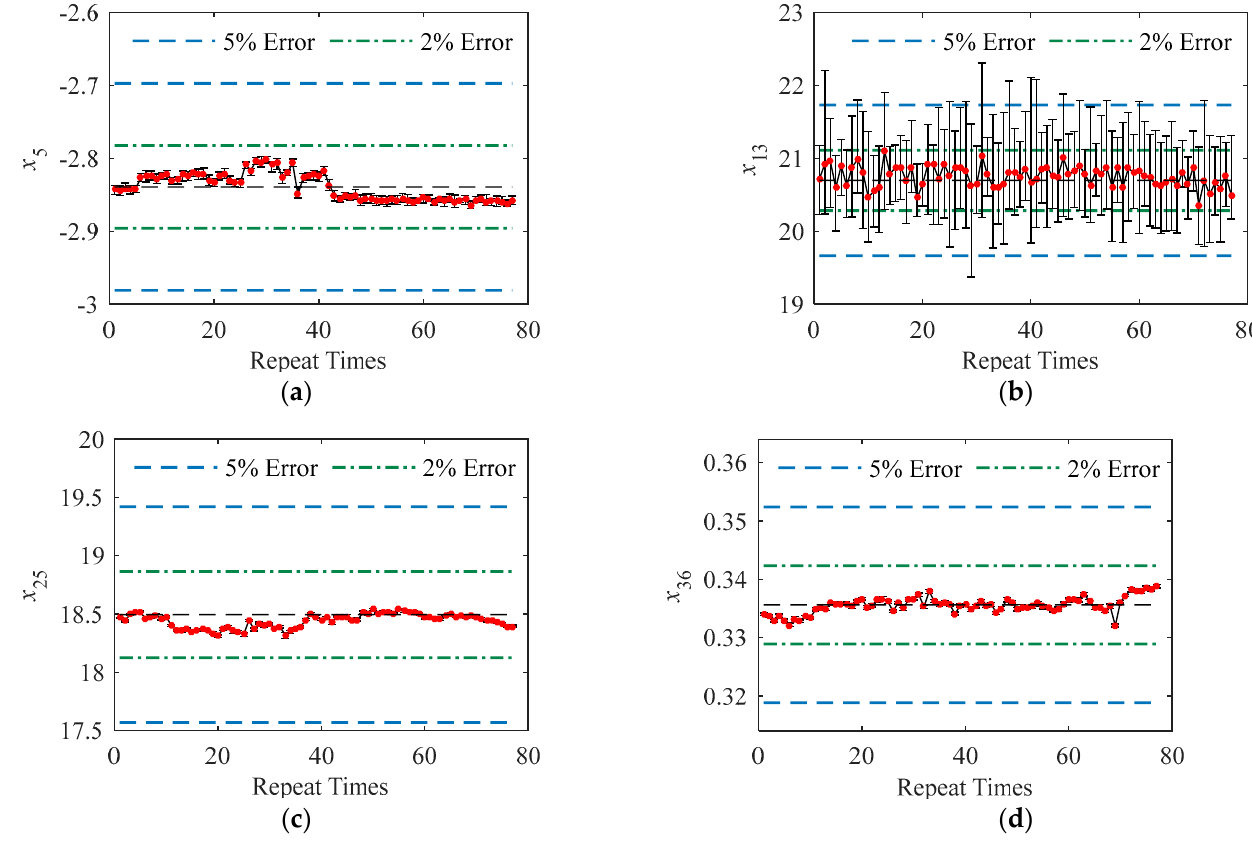
Figure 3. ( a – d ) demonstrate the recorded data of x 5 , x 15 , x 20, and x 36 , respectively.